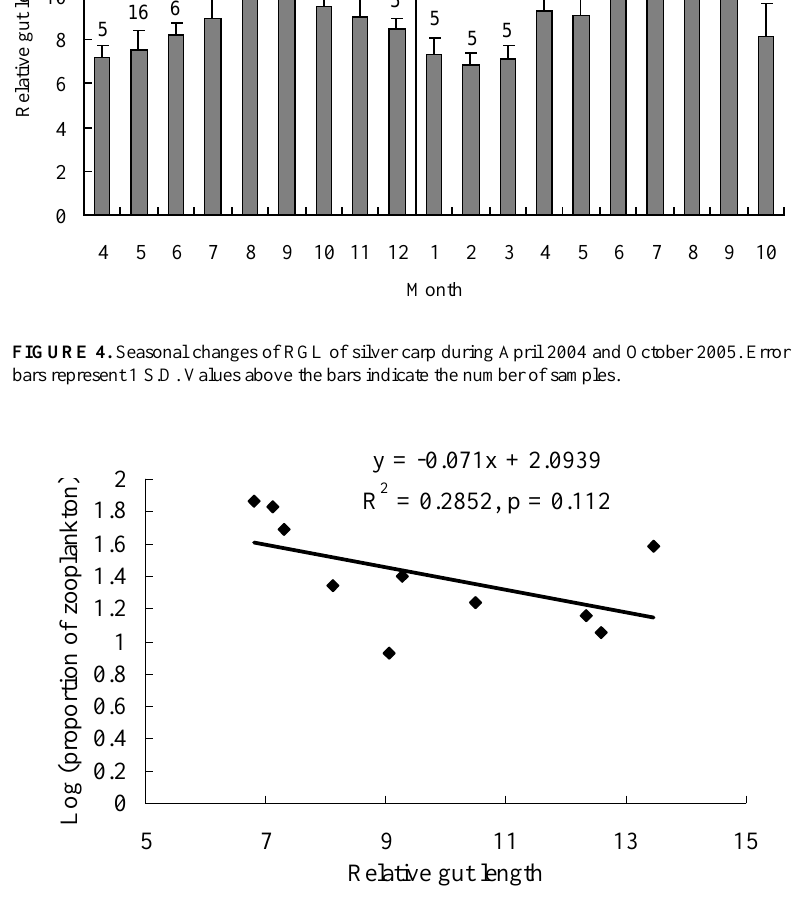
FIGURE 5. The relationships between RGL of silver carp and proportion of zooplankton in the diet from January to October in 2005.